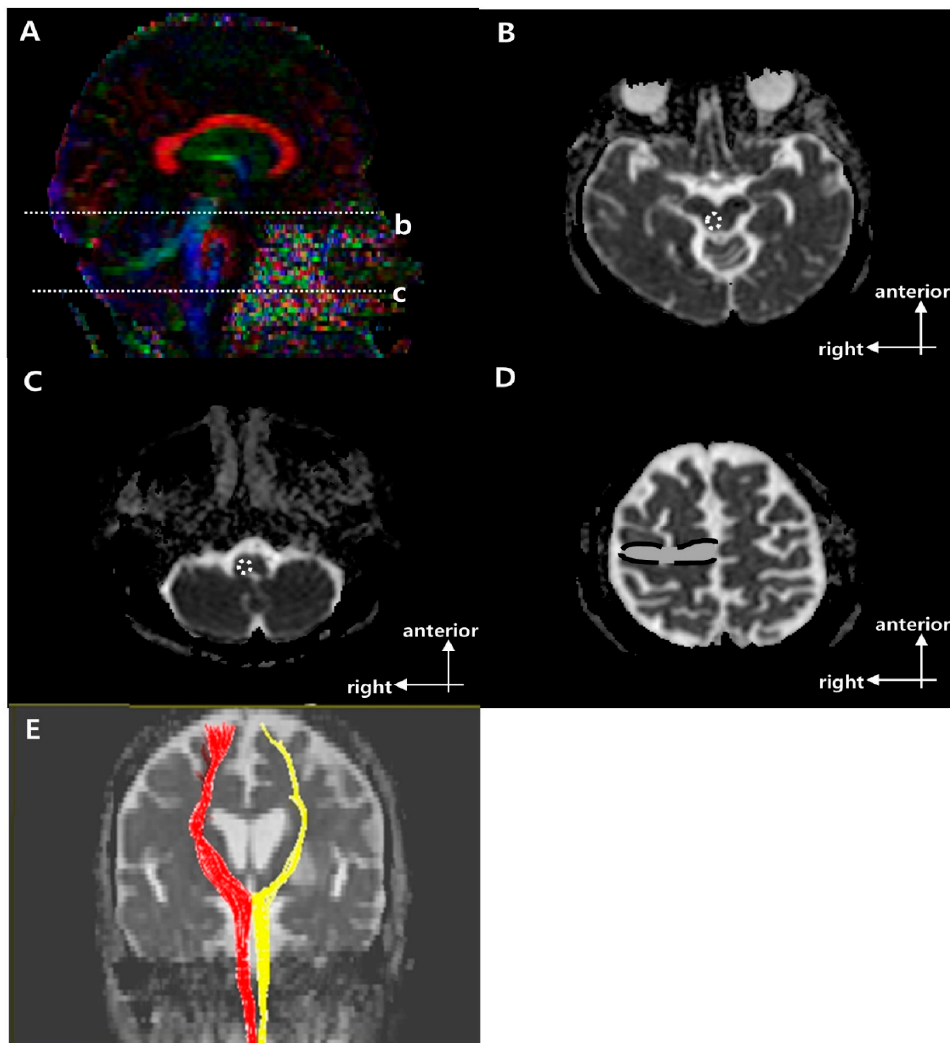
Figure 2. Regions of interest (ROIs) used to reconstruct the right corticoreticular pathway (CRP) on diffusion tensor imaging (DTI) and representative diffusion tensor tractography (DTT) images of the CRP [9]. ( A ) Sagittal color fractional anisotropy (FA) map with dotted lines showing the (b) reticular formation of the medulla and (c) midbrain tegmentum. ( B ) The dotted circle indicates the target ROI of the CRP at the midbrain tegmentum in the axial b = 0 image (level b in ( A )). ( C ) The dotted circle indicates the seed ROI of the CRP at the reticular formation of the medulla in the axial b = 0 image (level c in A). ( D ) The dotted line indicates the second target ROI of the CRP in Brodmann area 6 on axial b = 0 image. ( E ) Representative DTT image of CRP in a typical subject with a left middle cerebral artery (MCA) infarction (red, unaffected side; yellow, affected side).